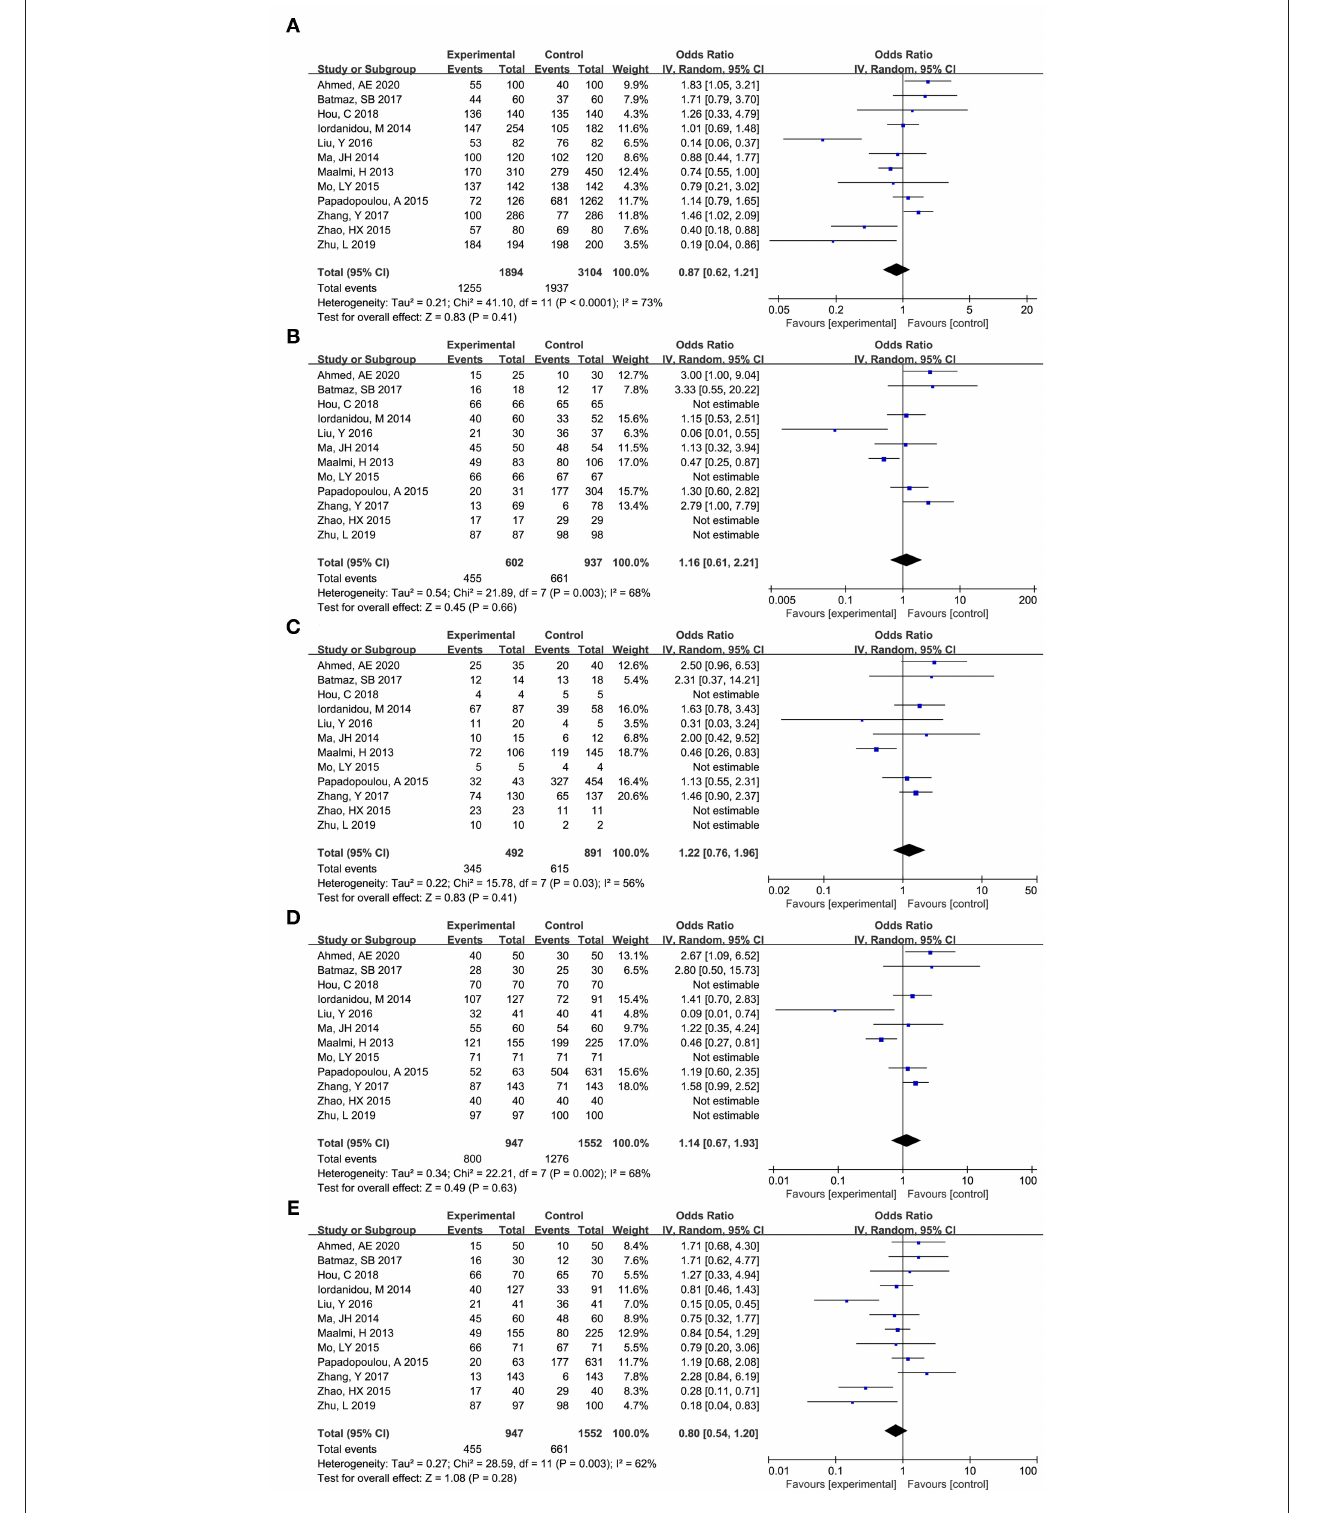
FIGURE 4 | Forest plot for meta-analyzing the association between Vitamin D receptor BsmI (rs1544410) polymorphisms and childhood asthma. (A) additive model: b vs. B; (B) co dominant model: bb vs. BB; (C) co dominant model: Bb vs. BB; (D) dominant model: bb + Bb vs. BB; (E) : recessive model: bb vs. BB + Bb.